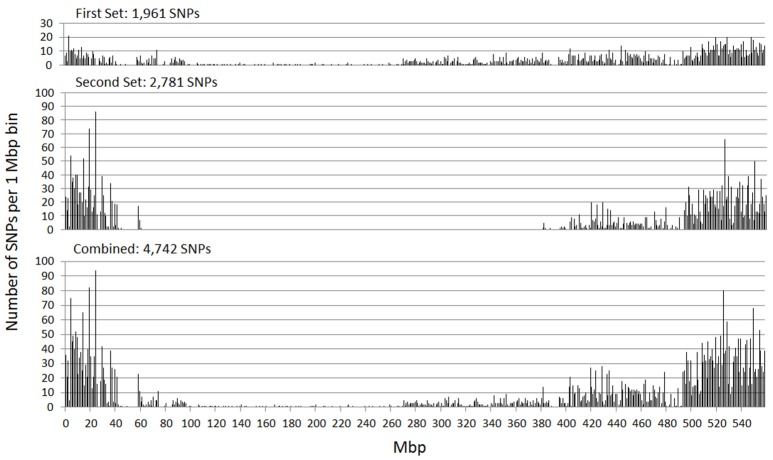
Physical distribution of the SNPs in the initial SNP set, the additional set targeted at markers in the distal chromosome regions, and the combination of these two sets (chromosome 1H).